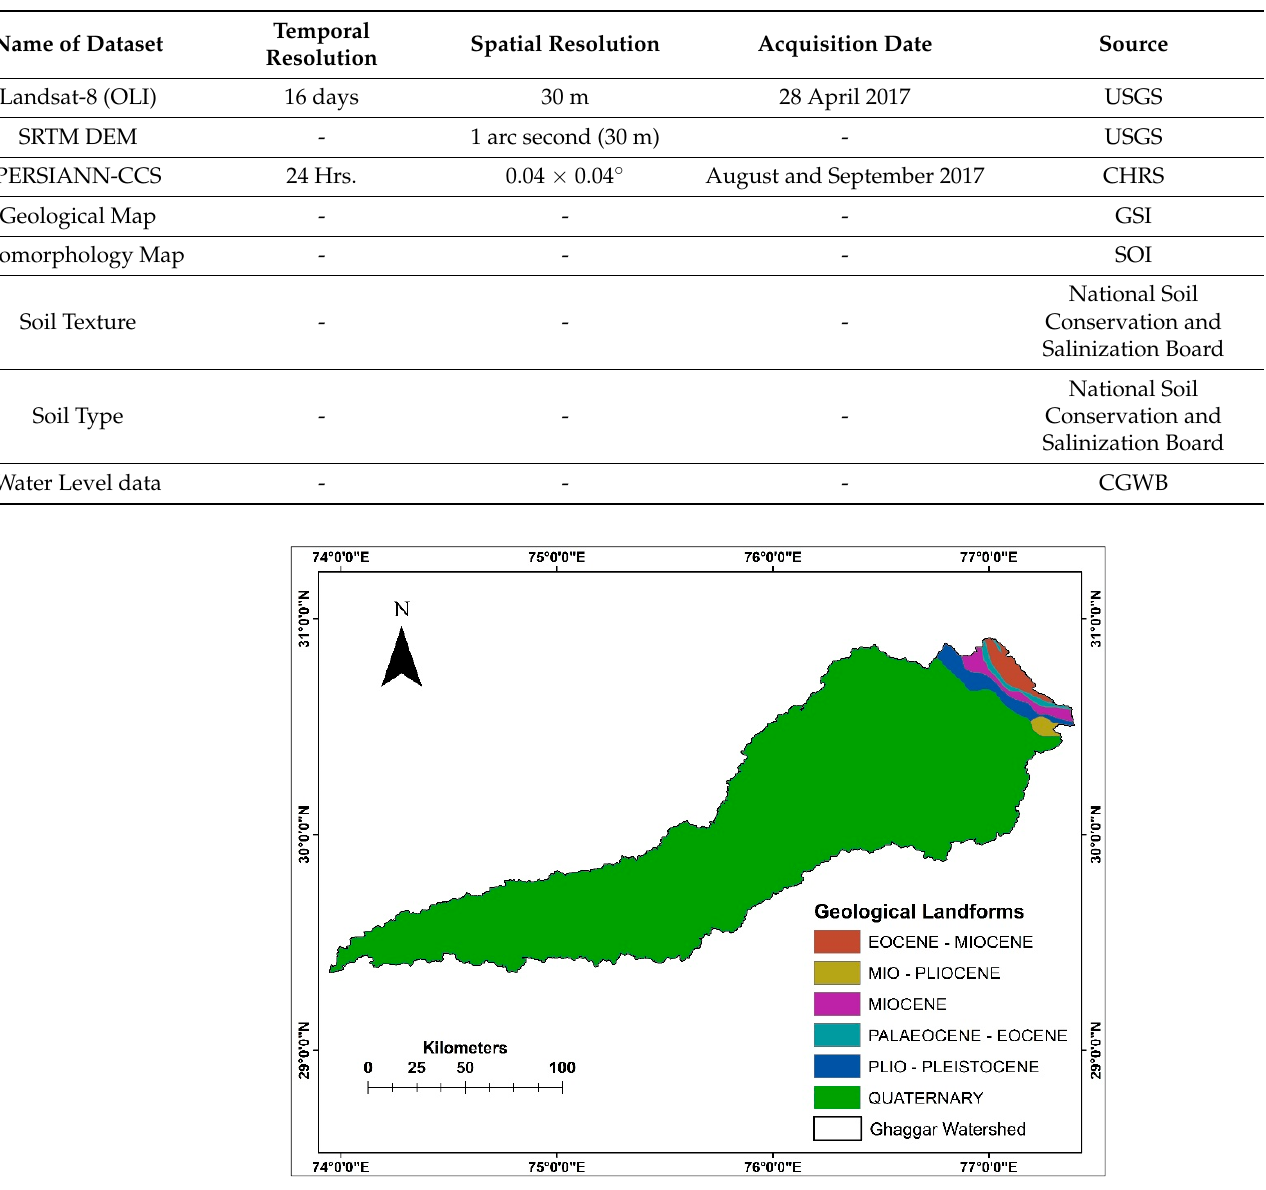
Figure 2. Geological map of the study area (stratigraphic formations included) (Source: Geological Survey of India). Survey of